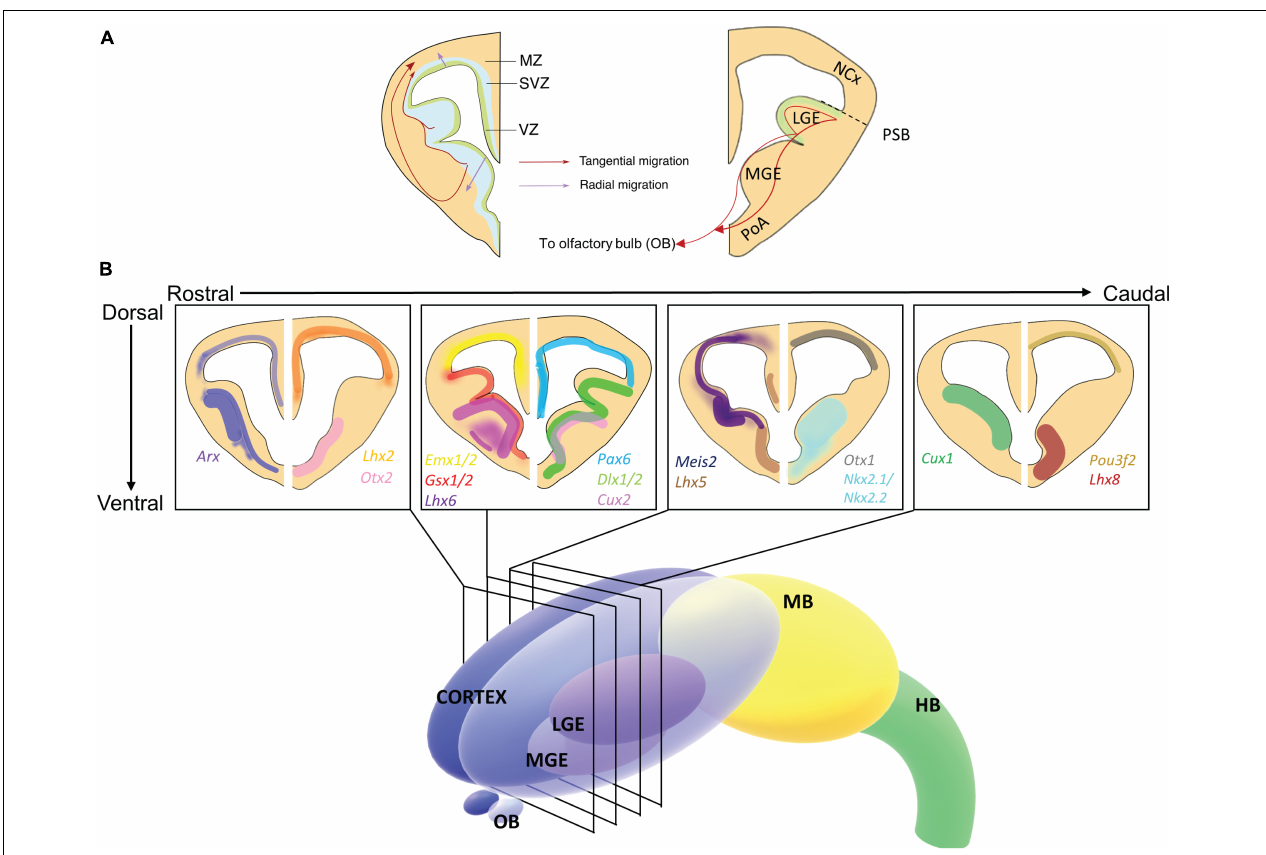
FIGURE 1 | Expression of homeobox genes in the developing embryonic mouse forebrain. (A) Schematic illustration of coronal section of E13.5 forebrain depicting ventricular zone (VZ), subventricular zone (SVZ), and mantle zone (MZ) on the left-hand side and neocortex (NCx), lateral ganglionic eminence (LGE), and medial ganglionic eminence (MGE) on the right-hand side. The VZ and SVZ are the proliferative zones, comprised of progenitor cells. Depending on the identity of these differentiated cells, the cells migrate either tangentially (red arrows) or radially (purple arrows) into the MZ and proceed to mature (Left-hand side). Migration toward the olfactory bulb from the VZ of the LGE also occurs (Right-hand side). (B) 3-dimensional schematic of the developing forebrain. The LGE and MGE are contained within the cortex, above the olfactory bulbs (OB). The midbrain (MB) and hindbrain (HB) are also labeled. Insets show schematic representations of 4 coronal sections taken from the forebrain depicting the expression of key homeobox gene expression patterns from rostral to caudal at embryonic time point E13.5. Gene name colors correspond to the expression color shown in the section. Transcription factor expression can be overlapping or structurally distinct and is related to the function of the individual transcription factor (Allen Institute for Brain Science, 2019). Arx and Meis2 , to an extent, are expressed throughout the forebrain, whereas Lhx2, Emx1/2, Pax6, Otx1, and Pou3f2 are expressed in the neocortex and pallium. Dlx1/2, Gsx1, Otx2 , and Cux1 are expressed in the GE, Gsx2 is expressed specifically in the LGE, and Nkx2.1, Cux2, Lhx6 , and Lhx8 in the MGE. Irx3 is not depicted here as it is expressed in the thalamus (not shown). For detailed depictions of gene expression patterns, readers are encouraged to review the cited primary references or the Allen Brain Atlas: Developing Mouse Brain